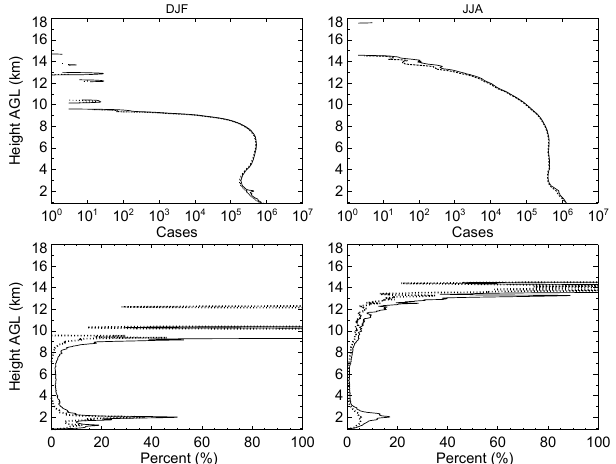
Figure 8. The upper panel shows the number of occurrences of the detected hydrometeor range bins from the two methods. The solid line is the number of range gates derived from our method. The dotted line from the ARM MMCR algorithm. The lower two pan- els demonstrate the increased percentage of hydrometeor bins from our method comparing to the ARM MMCR algorithm. The solid line is calculated by applying both noise reduction and central-pixel weighting schemes, while the dashed line is calculated by only ap- plying the central-pixel weighting scheme in our detection method.